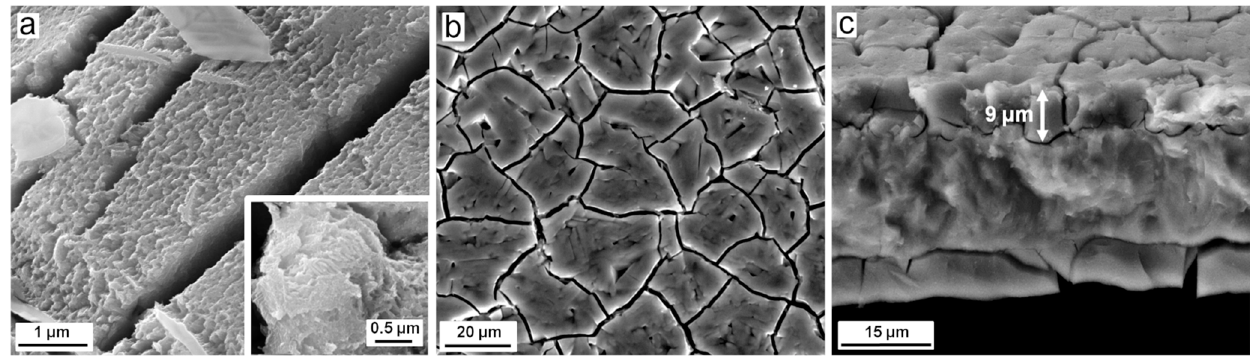
Scheme 1. Scheme demonstrating the overall free corrosion process.